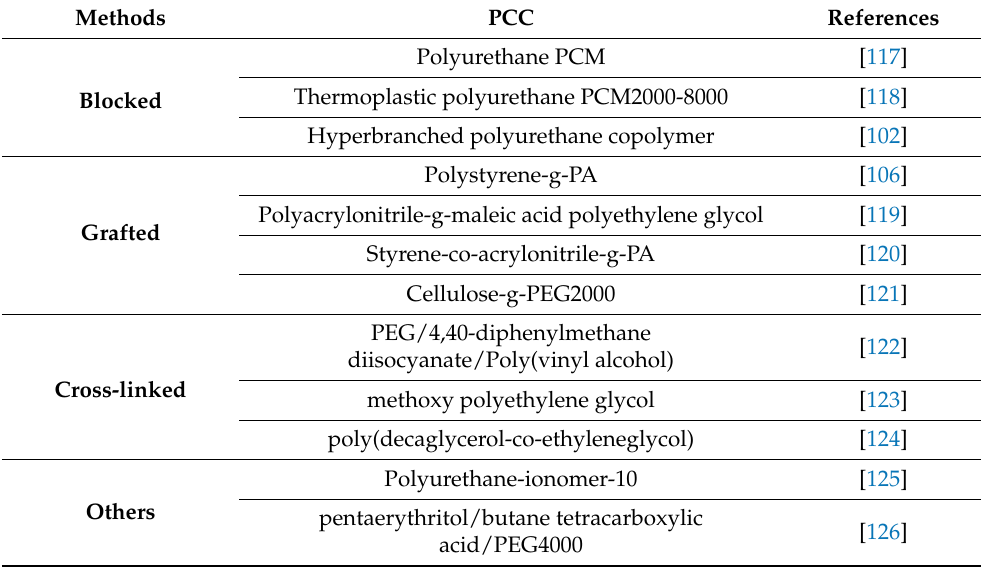
Table 4. Summary of different PCCs using different techniques of PCM